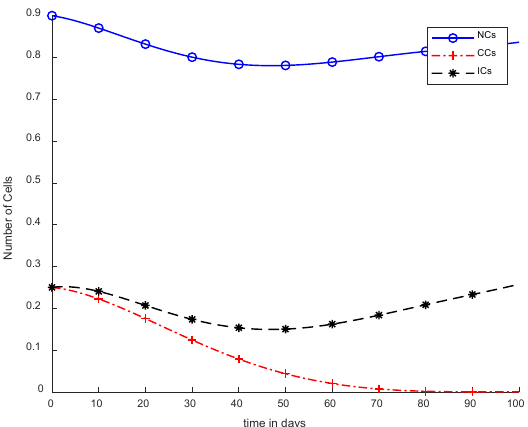
Figure 6. With chemotherapy at a continuous dose and without controller.